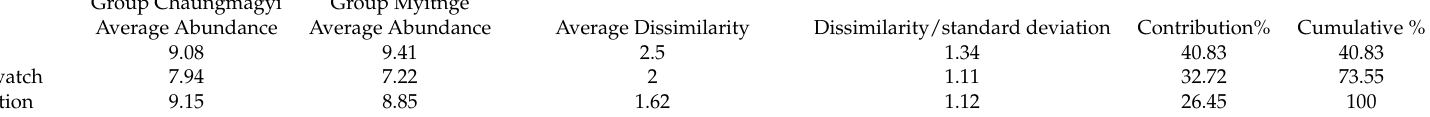
Group MT Average similarity: